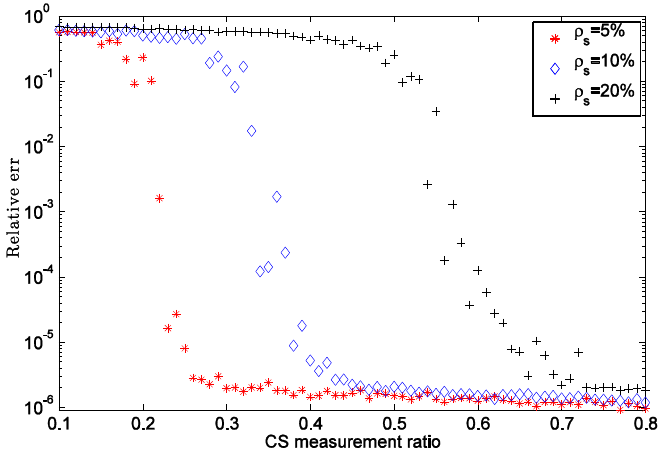
Figure 2. Sparse recovery performance with respect to CS measurement ratio.